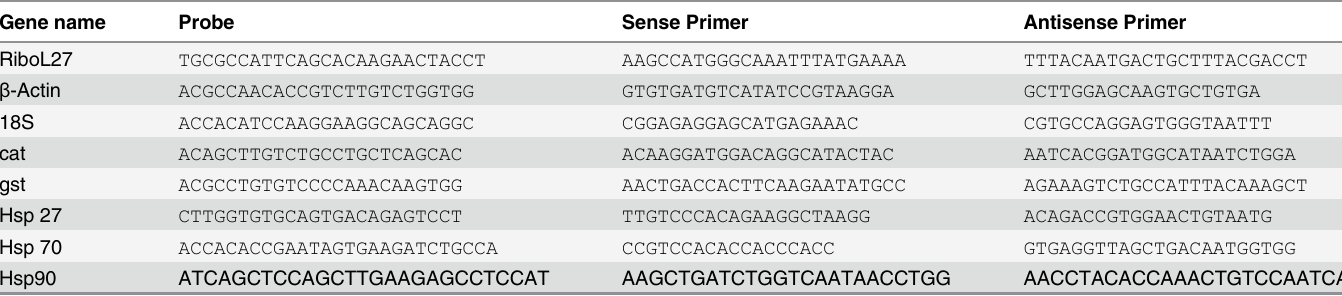
Table 1. Q-PCR primers and Taqman